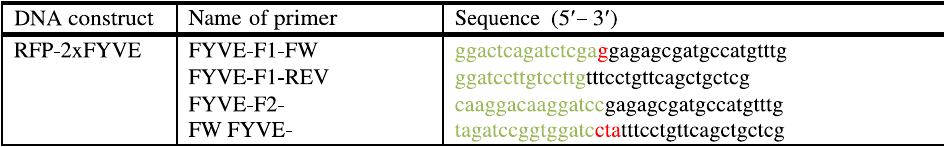
Guide RNAs used for CRISPR/Cas9-mediated gene knockout of TECPR1 and ATG16L1. Added Bbs I restriction sites are indicated in blue and additionally added G – C pairs are indicated in